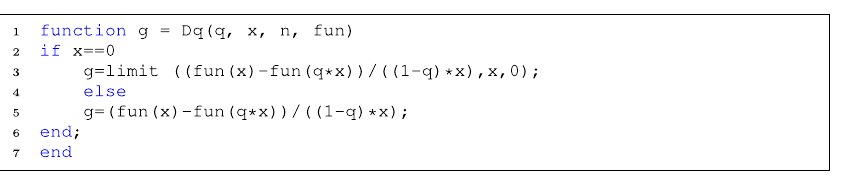
Algorithm 3 The proposed method for calculated ( D q f )( x